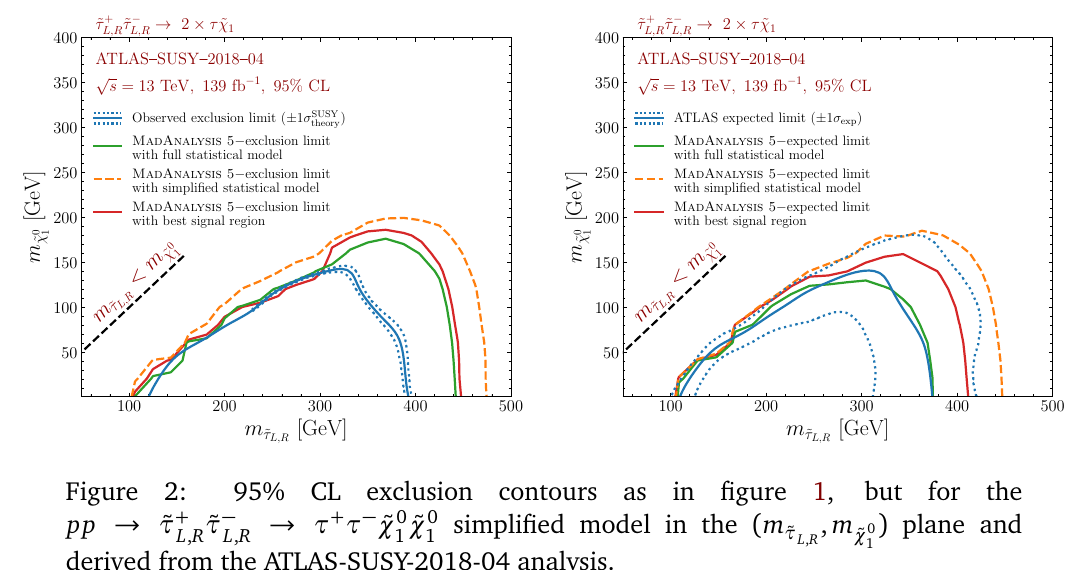
) plane and , m ˜ τ L , R ˜ χ 0 1